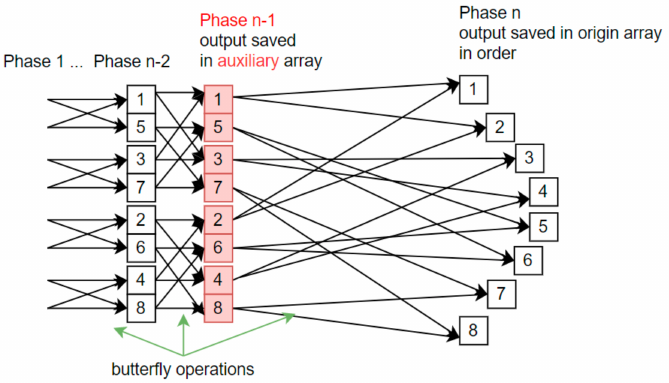
Figure 2. Fast Fourier Transform with Stockham algorithm adaptation; auxiliary array (red) used for implicit reordering.